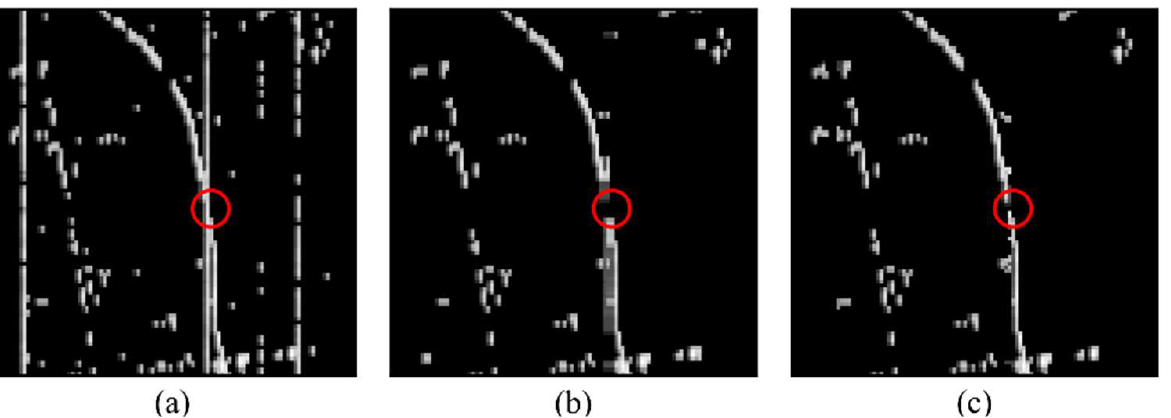
Figure 13. Information loss of different stripes restore methods. ( a ) Original image. ( b ) The neighborhood averaging method. ( c ) The method based on spectral similarity. ( a – c ) The red circle emphasizes the effect of different stripes restore methods. 3. The ADSSR algorithm is mainly based on subjective characteristics of images and stripes. Although it is applicable to most images, the subjective characteristics of im- ages and stripes cannot perfectly summarize the actual characteristics in the case of complex weather conditions and poor original image quality, so the performance of the ADSSR algorithm will be degraded. As shown in Figure 14, a cloudy image with invalid relative radiometric correction parameters is selected for testing. Although most of the stripes can be removed, the residual stripe noise is more obvious than that of the cloudless image. Fortunately, the availability of such images is not high.